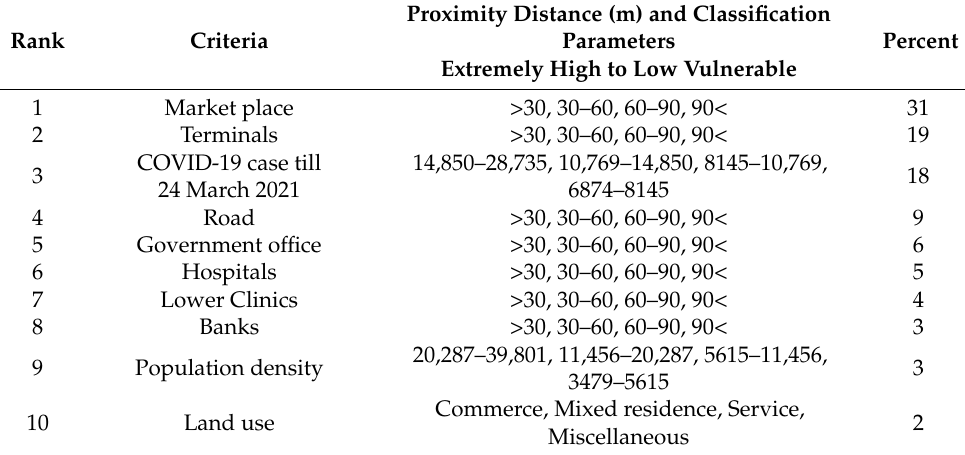
Table 3. Factor’s classification parameters.